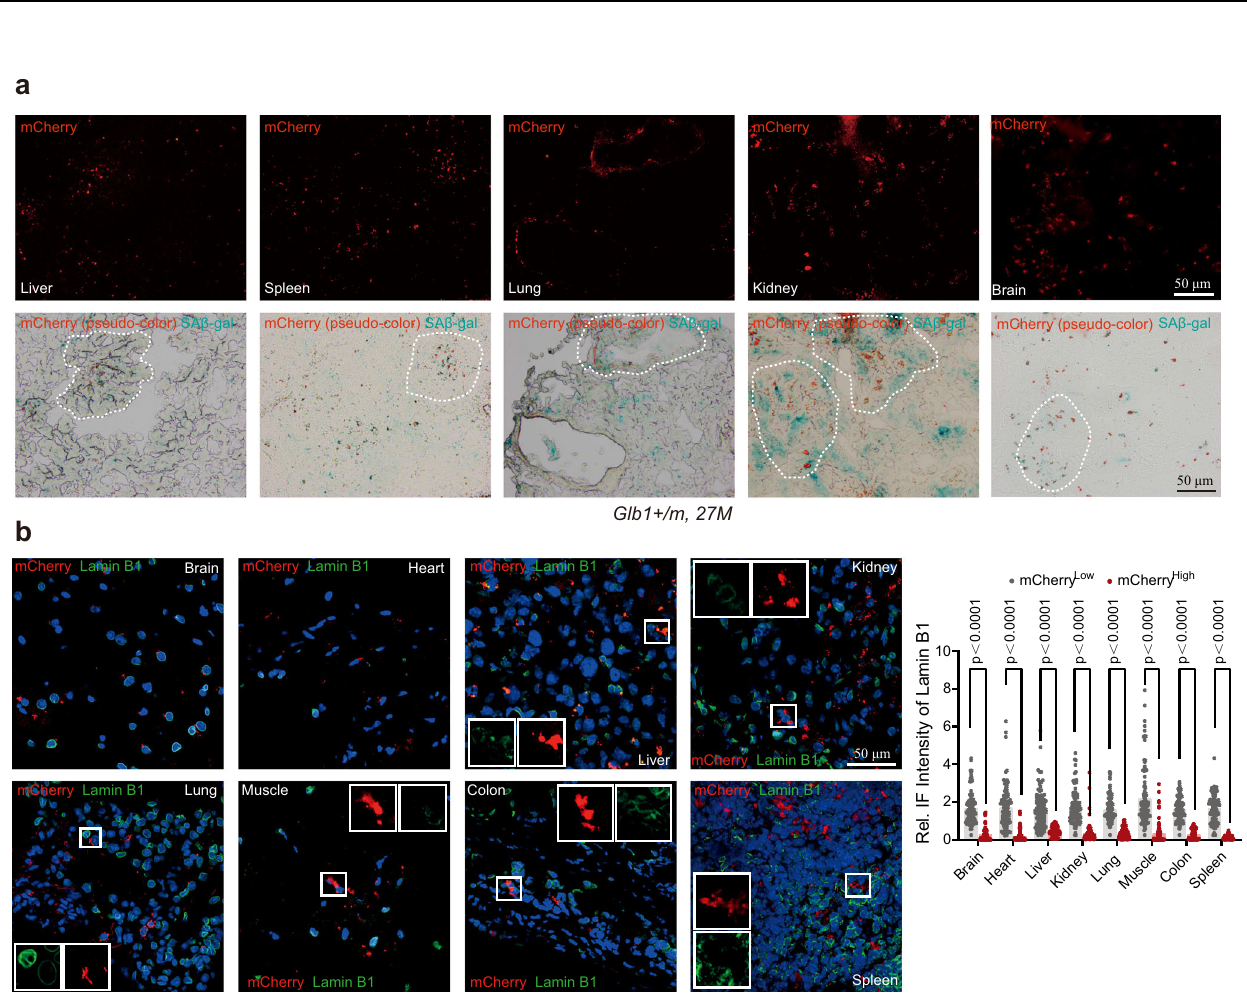
Fig. 2 | Characterization ofGAC reporter atcellular levels. Relative mRNA levels of Glb1 and mCherry ( a ) and representative western blots showing the corre- sponding protein levels ( b ) in lung tissues from indicated mice. WT, Glb1 +/+ mice (15months,female, n =3);HE, Glb1 +/m heterozygousmice(15months,female, n =3); HO, Glb1 m/m homozygous mice (15 months, female, n =3). c Linear correlation between the mRNA levels of Glb1 and mCherry in passages 1 to 5 of Glb1 +/m MEF. d Representative images showing elevated mCherry fl uorescence signal in Glb1 +/m MEFs at P7. Arrows indicate senescent cells. e Representative images showing increased SA β -gal staining (left) and mCherry protein levels (right) in Glb1 +/m MEFs at P5. Arrows indicate senescent cells. f Representative images showing the co- existenceofmCherrysignalandantip16 Ink4a fl uorescencestaining(green)in Glb1 +/m MEFs during replicative senescence. Relative fl uorescence staining intensity was